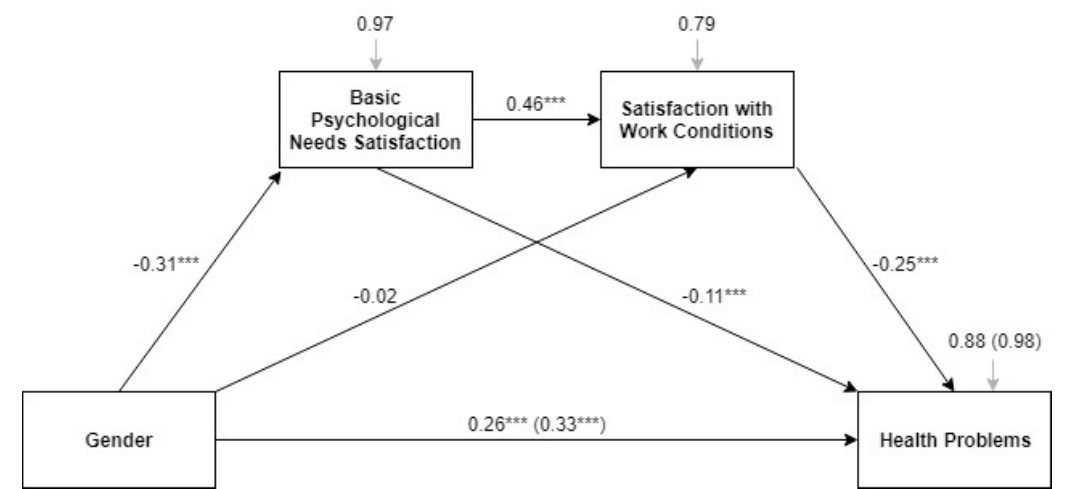
Figure 4. Model of the multiple partial mediation of basic needs and satisfaction with work conditions in the effect of gender on health problems among European health professionals. Note: *** p < 0.001. Source: Own elaboration from the data of the 6th EWCS 2016. © European Foundation for the Improvement of Living and Working Conditions (Eurofound), 2018 [41].